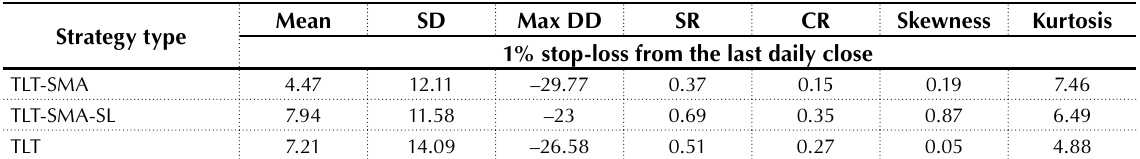
Table 6. Summary statistics of TLT-SMA with daily stop loss January 1, 2004 – October 13, 2015 Mean SD Max DD SR CR Strategy type